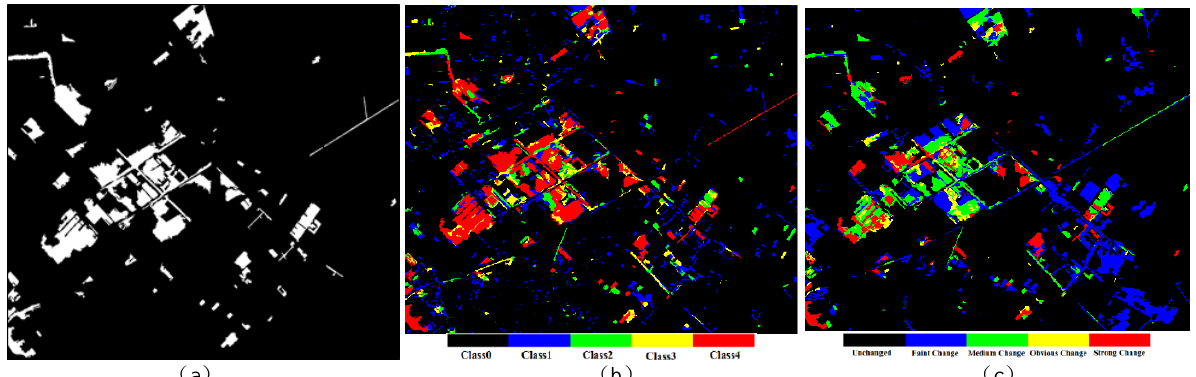
Figure.8 The results of Multi-scale fusion (a) Fuzzy fusion (b) Decision level fusion 1 (c) Decision level fusion 2